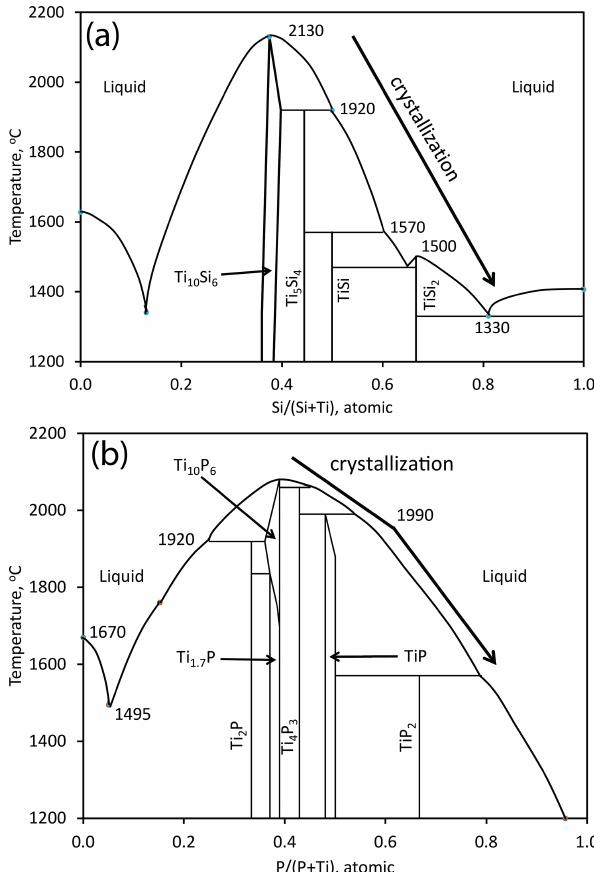
Figure 10. (a) The Ti–Si binary (modified from Fiore et al., 2016, Fig. 2a) (b) The Ti–P binary (modified from Ohtani et al., 2006, Fig. 5a; Okamoto, 2007, Fig. 1). The arrows show the inferred crys- tallization sequence in the two binary systems corresponding to the crystallization sequence in the ternary system (Fig. 9).